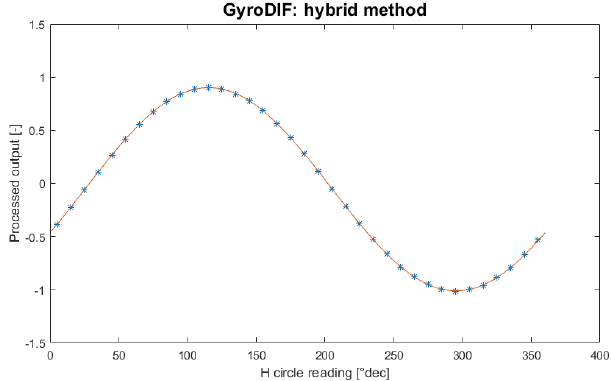
Figure 7. Fiber-optic gyro output signal due to Earth’s rotation when its sensitive axis scans the horizontal plane in Dourbes. The maximum of the sine function corresponds to true north. Blue: hy- brid method ω r according to Eq. (11). Red: sinus fitting.